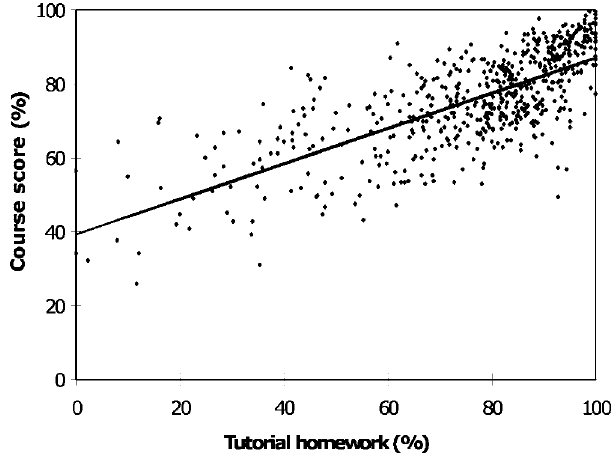
FIG. 2. Correlating overall performance in course (cid:1) course score includes all graded elements except tutorial homeworks, expressed as a percent of total possible (cid:2) with tutorial homework score. Data shown are for fall 03. The correlation coefficient is r =0.73 (cid:1) N =562 (cid:2) . The solid line shows a best fit (cid:1) regression (cid:2) to the data. Data for spring 2004 look very similar; the correlation coefficient is r =0.65 (cid:1) N =513 (cid:2) .